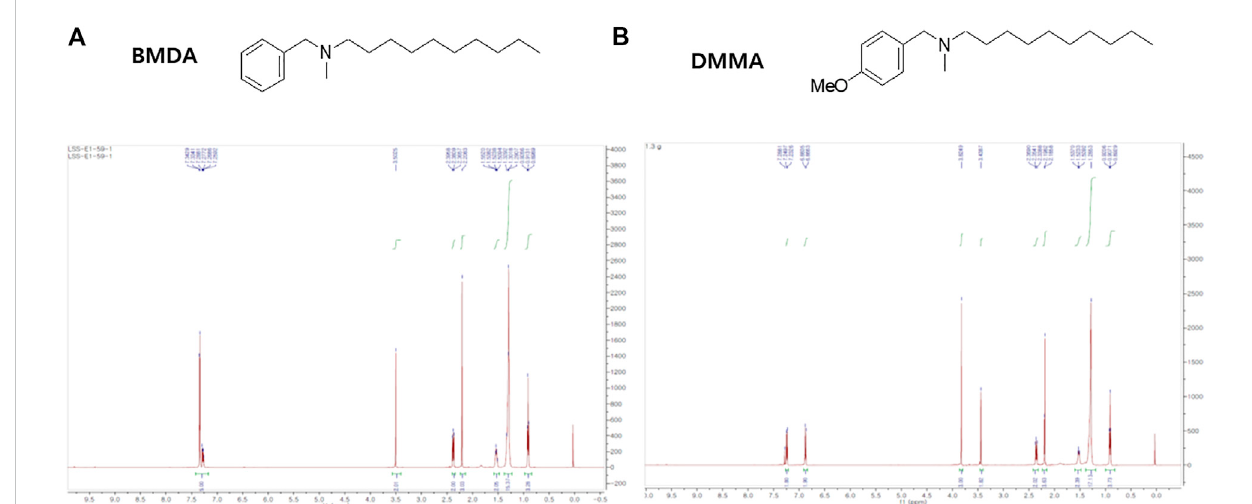
FIGURE 1 Structure and identi fi cation of BMDA and DMMA (A) Structure and 1 H-NMR result after the synthesis of BMDA. (B) Structure and 1 H-NMR result after the synthesis of